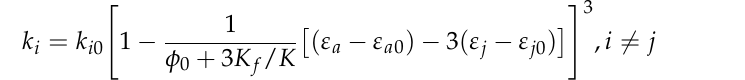
Figure 2. Solving process of the coupled damage–stress–seepage model of coal seams.